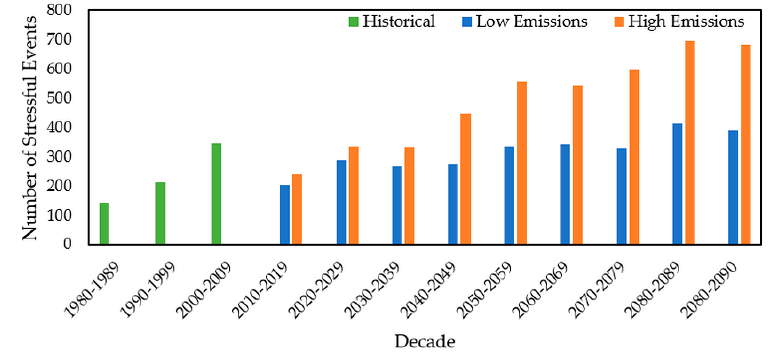
Figure 13. Number of stressful events predicted in the Queen River watershed between 1980 and 2099 under historical conditions, low CO 2 emissions and high CO 2 emission scenarios.